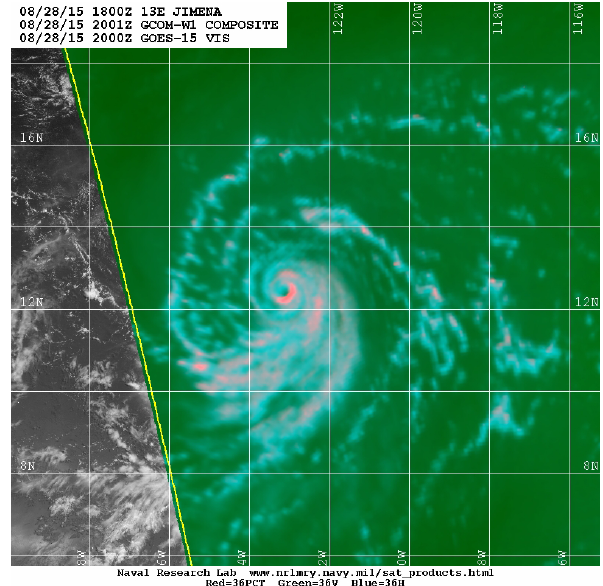
Figure 8. Naval Research Laboratory 37GHz color image from the Advanced Microwave Scanning Radiometer 2 (AMSR2) at 20:00UTC, 28 August 2015 (credit to NRL Satellite Team). The satellite image can be obtained at https://www.nrlmry.navy.mil/TC. html (last access: 22 November